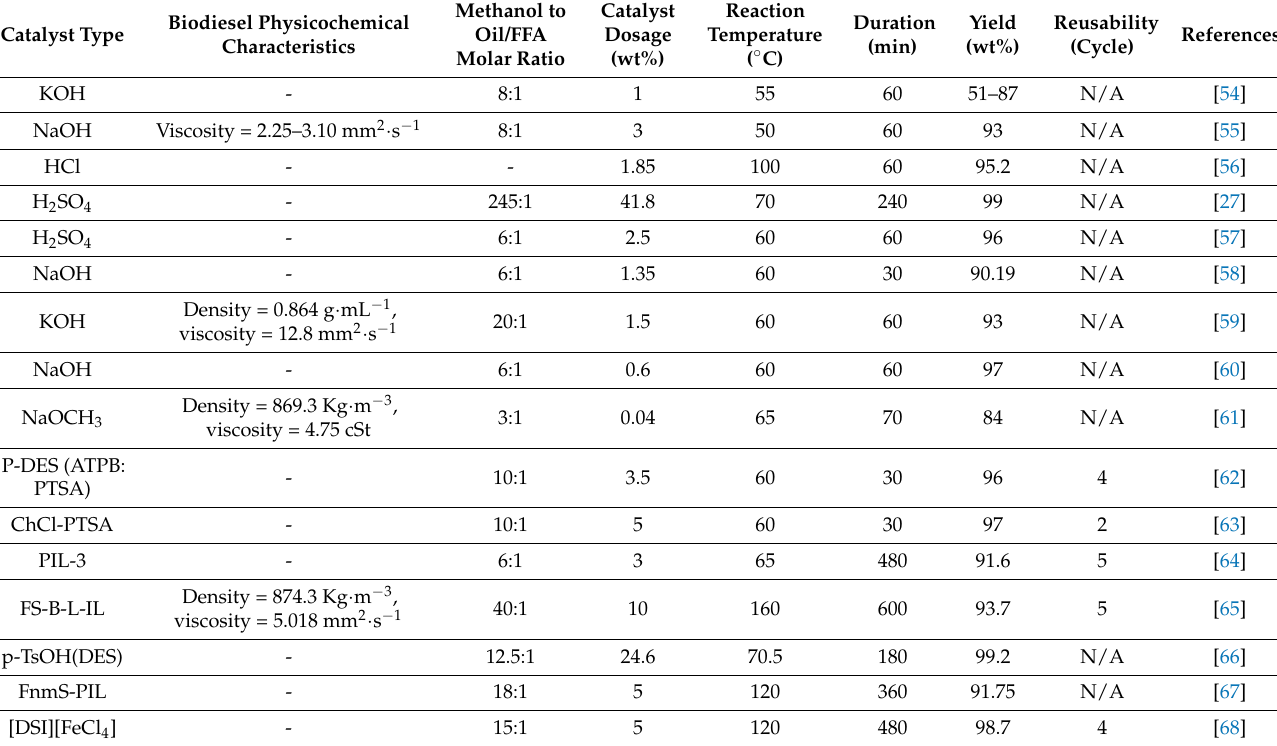
Table 2. Homogenous catalysts used for biodiesel production along with the yield and reac- tion